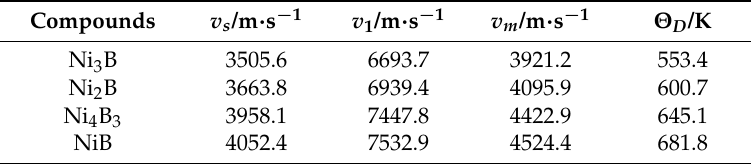
Table 6. Theoretically calculated thermal properties of the Ni x B y compounds, including v s , v 1 , v m , and Θ